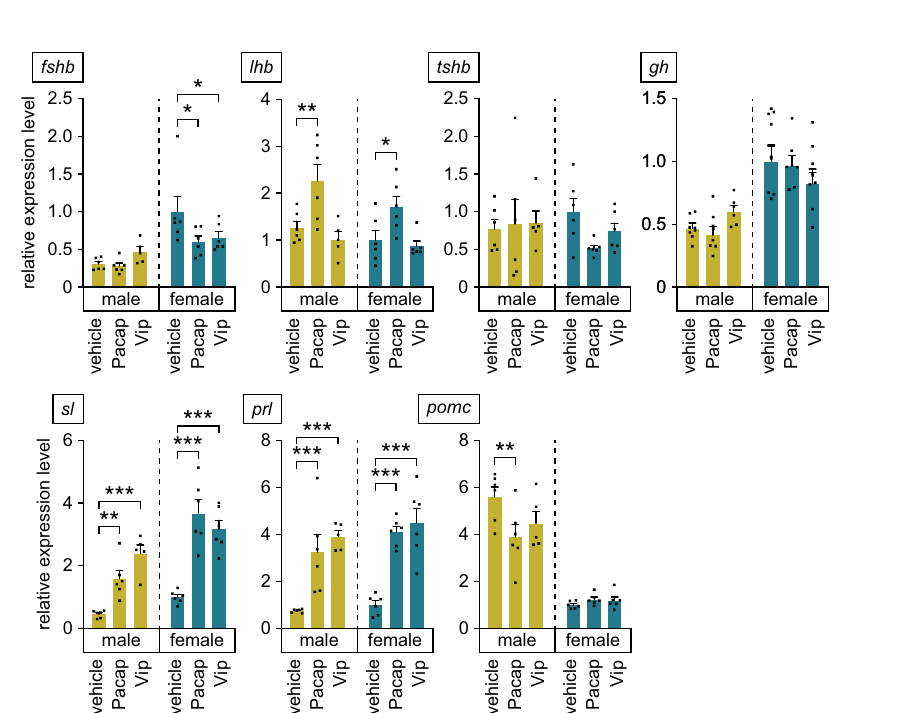
Fig. 7 Multiple Pacap/Vip receptors, including a male-predominant subtype, are expressed in the anterior pituitary. a Phylogenetic tree showing the relationship of medaka Pacap/Vip receptors to those of other species. The number at each node indicates bootstrap values for 1000 replicates. Scale bar represents 0.1 substitutions per site. SCTR, secretin receptor. For species names and GenBank accession numbers, see Supplementary Table 2. b Ability of Pacap and Vip to activate medaka Pacap/Vip receptors. Receptor activation was assessed by measuring cAMP-responsive element-driven luciferase activity in cells transfected with the indicated receptors. x -axis shows the concentration of Pacap and Vip; y -axis shows the fold change in luciferase activity relative to the basal level, which was measured in the absence of Pacap/Vip. c Expression of Pacap/Vip receptors in the pituitary. Representative sections of pituitary at different levels along the anterior – posterior axis are shown. Arrowheads indicate expression signals. Scale bars represent 50 μ m. d Total area of vipr2b expression signals in the male and female pituitary ( n = 3 per sex). e Representative micrographs showing male-biased expression of vipr2b in the pituitary. Scale bars represent 50 μ m. f Identity of the pituitary cells expressing each Pacap/Vip receptor. The spatial expression pattern of each receptor was compared with that of each pituitary hormone gene in the RPD and PI. Left and middle panels show images of the expression of the indicated receptor ( adcyap1r1a , adcyap1r1b , or vipr2b ; green) and pituitary hormone gene ( sl , prl , or pomc ; magenta) in the same sections; right panels show the merged images with nuclear counterstaining (blue). Arrowheads mark representative cells co-expressing the indicated receptor and pituitary hormone gene, while arrows mark the receptor-expressing cells that do not express the indicated pituitary hormone gene. Asterisks denote nonspeci fi c labeling of blood vessels. Scale bars represent 20 μ m. Quantitative data were expressed as means with error bars representing standard error of the mean. Statistical difference was assessed by unpaired t -test ( d ). *** p < 0.001. PI pars intermedia, PPD proximal pars distalis, RPD rostral pars distalis.